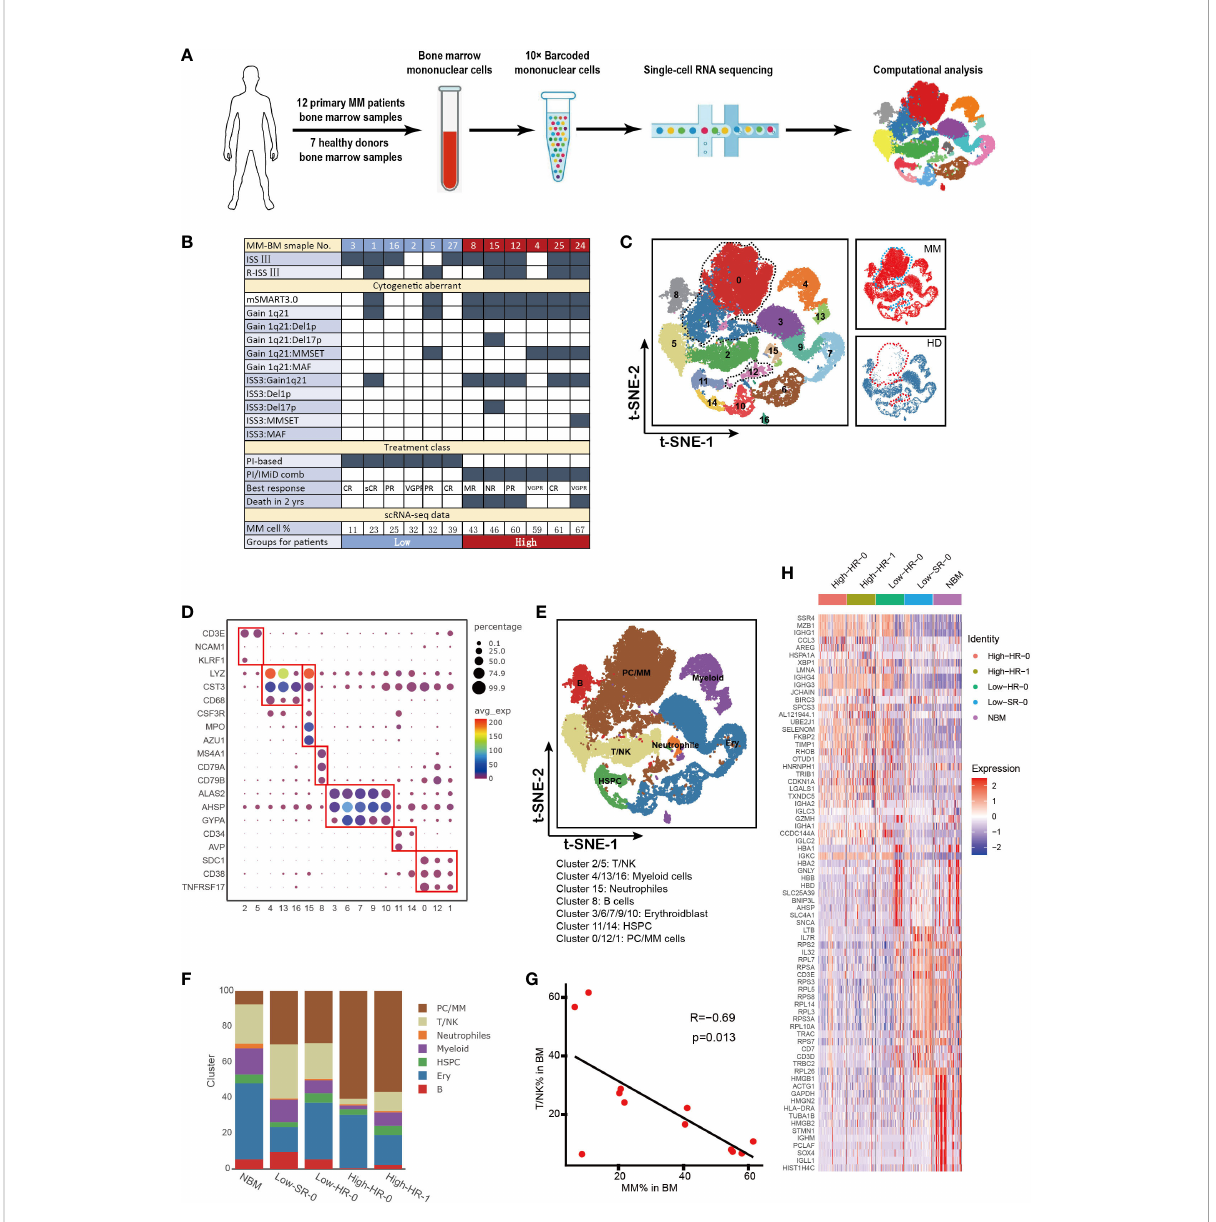
FIGURE 1 Cell identi fi cation in myeloma microenvironment at single cell resolution (A) . Flow chat of the study. BMNCs from 7 HDs and 12 NDMM patients were subjected to single-cell RNA sequencing on 10× Genomics platform. A total of 42,936 cells were analyzed after quality control. (B) . Form shows the detailed characteristics and clinical information of MM patients. (C) . Seventeen cell clusters were identi fi ed by t-SNE analysis of BMNCs from HD and MM patients. Each dot represents a single cell; colors indicate cell clusters with numbered labels. (D) . Bubble chart shows the expression of marker genes of distinctive cell type. The cluster number are presented in the bottom of the fi gure. (E) .t-SNE plot shows the distribution pattern of the BMNCs cell types. Colors represent different cell types. (F) . Bar charts show the proportions of distinctive cell type from HD and different MM groups. The cell types in right correspond to the ones in (E) . (G) . The correlation of proportion of T/NK and MM cells in MM patients. (H) . Heatmap shows the expression pro fi le of top 20 signature genes for T/NK clusters from HD and different MM groups. The top bars label the HD and MM groups. tSNE, T-distributed stochastic neighbor embedding; BMNCs, Bone marrow mononuclear cells; MM, multiple myeloma; NDMM, newly diagnosed MM; HD, healthy donors; T/NK, T cells and NK cells; B, B cells; PC/MM, plasma cells and multiple myeloma cells; Ery, erythroidblast; HSPC, hematopoietic stem and progenitor